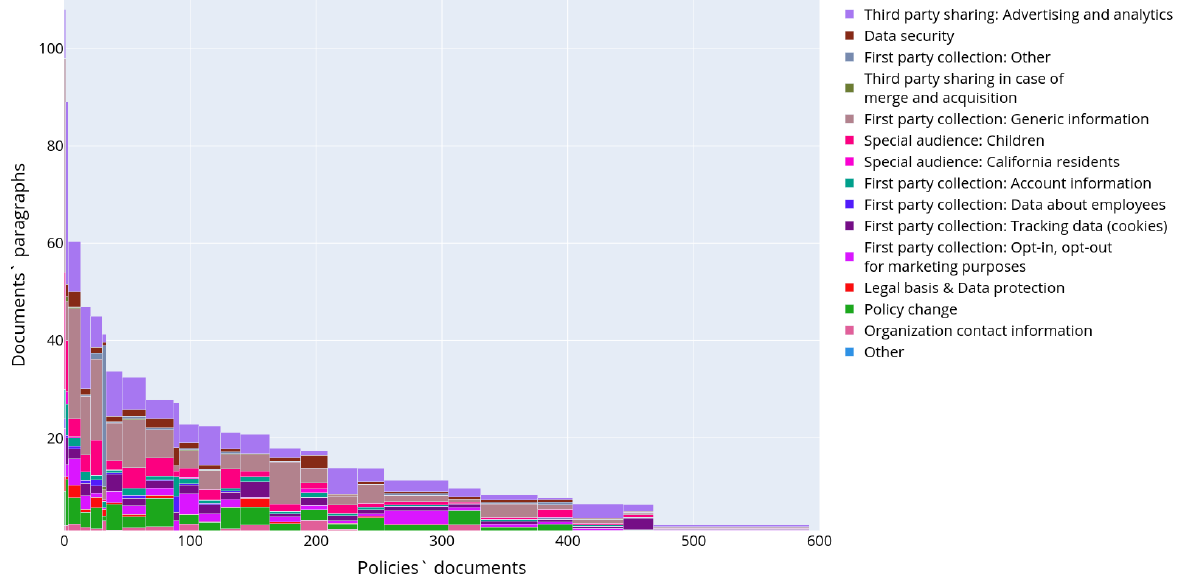
Figure 9. Distribution of the topics in the text of the privacy policies in IoT